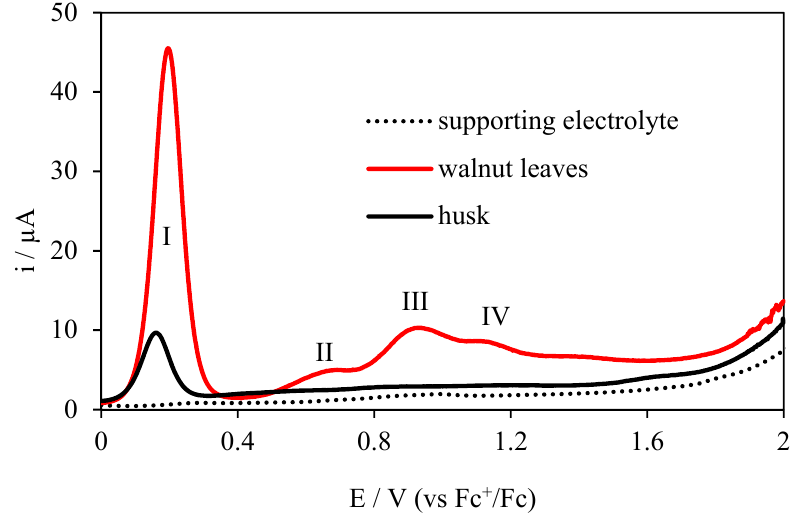
Figure 5. Differential pulse voltammograms (DPV) electrooxidation of extracts from walnut leaf and husks on the Pt electrode; c = 20 mg/dm 3 in 0.1 mol.L − 1 (C 4 H 9 ) 4 NClO 4 in acetonitrile.